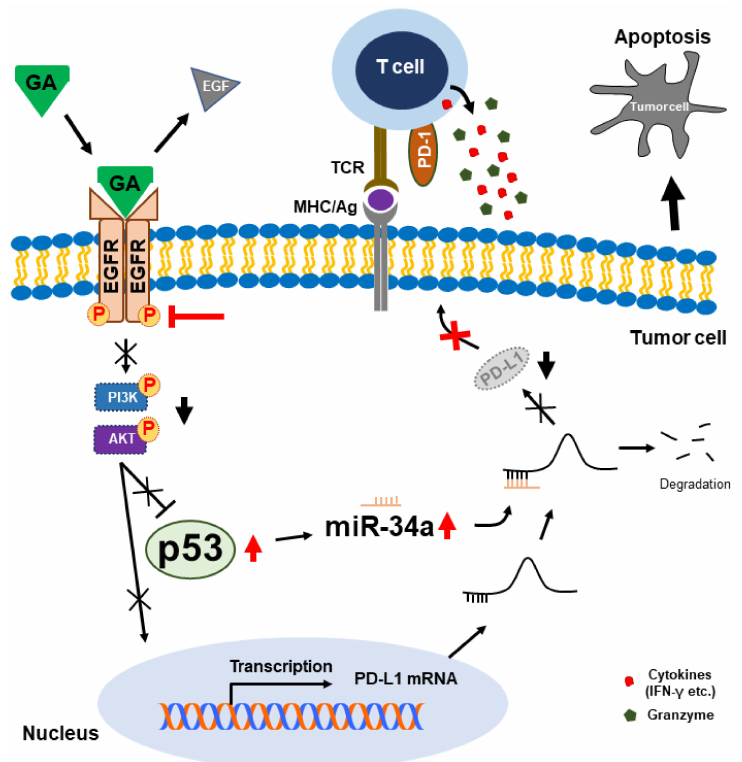
Figure 7. Molecular regulatory mechanism of programmed death-ligand 1 (PD-L1) by natural bioactive gallic acid in NSCLC cells and proposed combination e ff ect for NSCLC